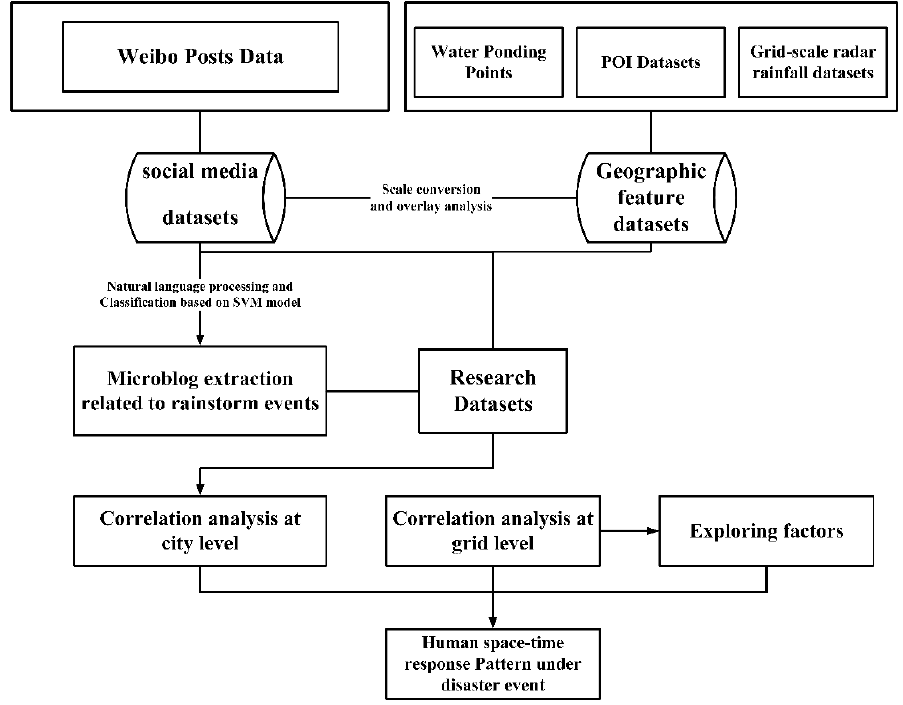
Figure 2. A flowchart showing the data processing and analysis processes.